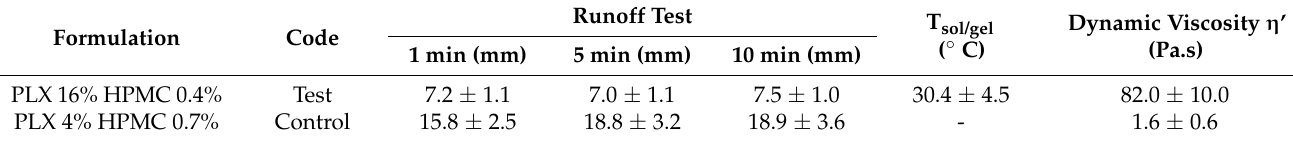
Table 1. Test and control formulation runoff distance, T sol/gel ( ◦ C), and viscosity. Runoff Formulation Code